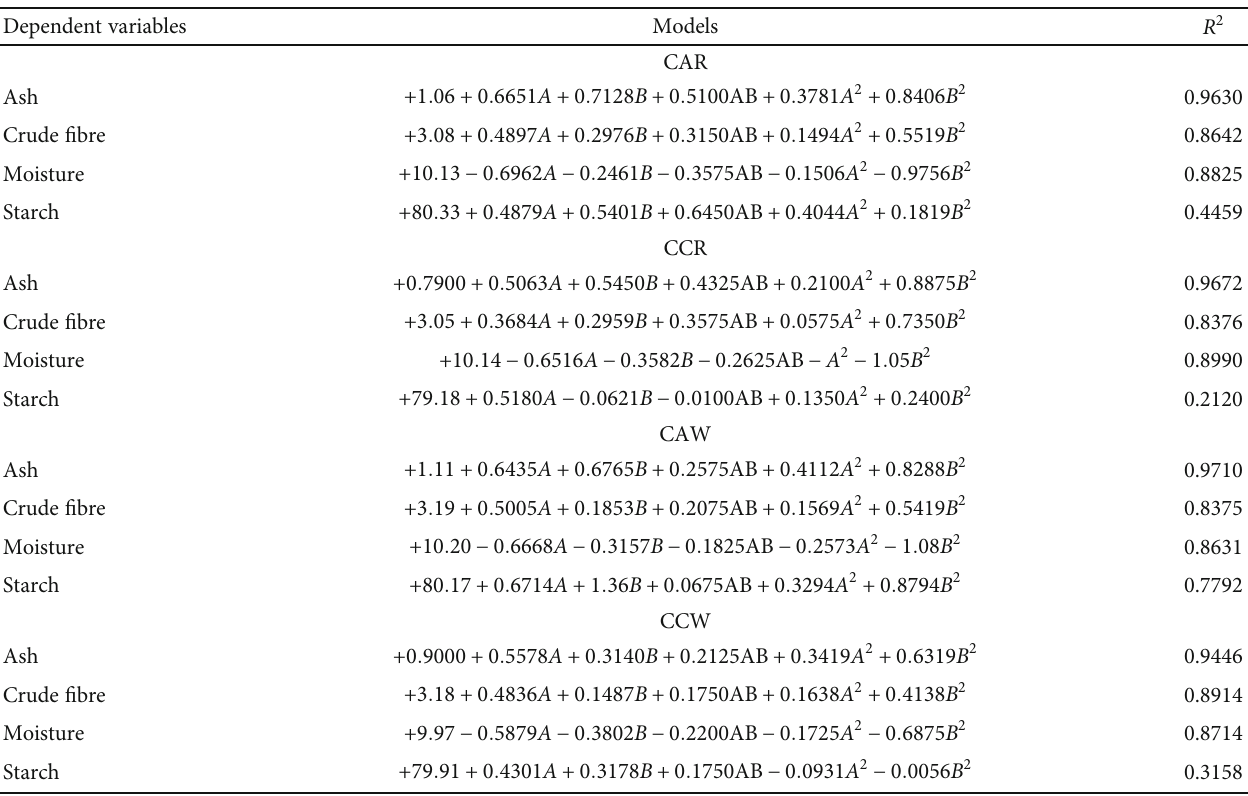
Table 3: Regression models relating proximate components of cassava fl our and model